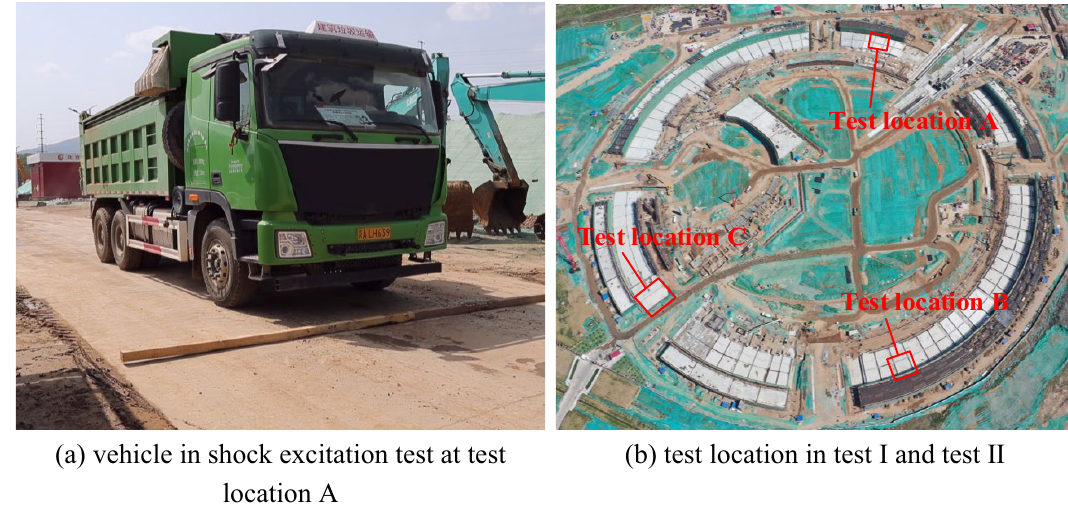
Figure 4. Vehicle in shock excitation test and test